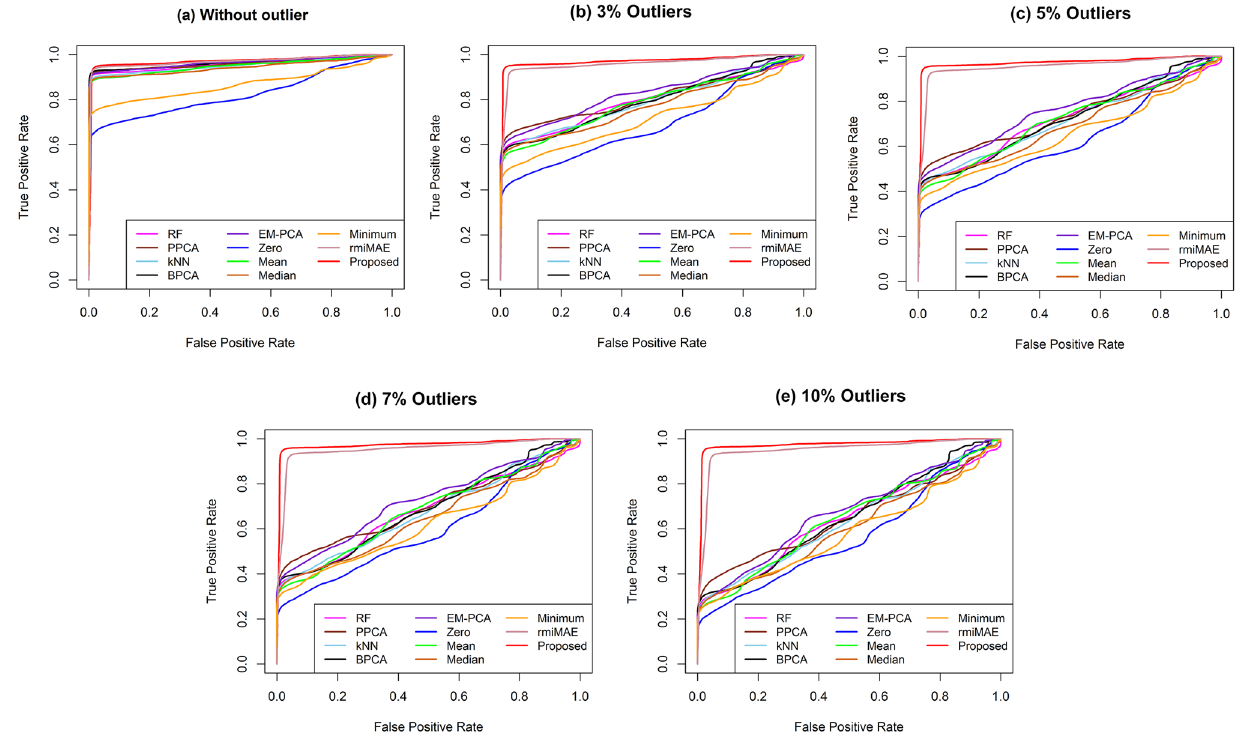
Figure 2. Performance investigation of different missing value imputation techniques using receiver operating characteristic curve of DE calculation for two class level dataset with 5% missing values in absence and presence of outliers.